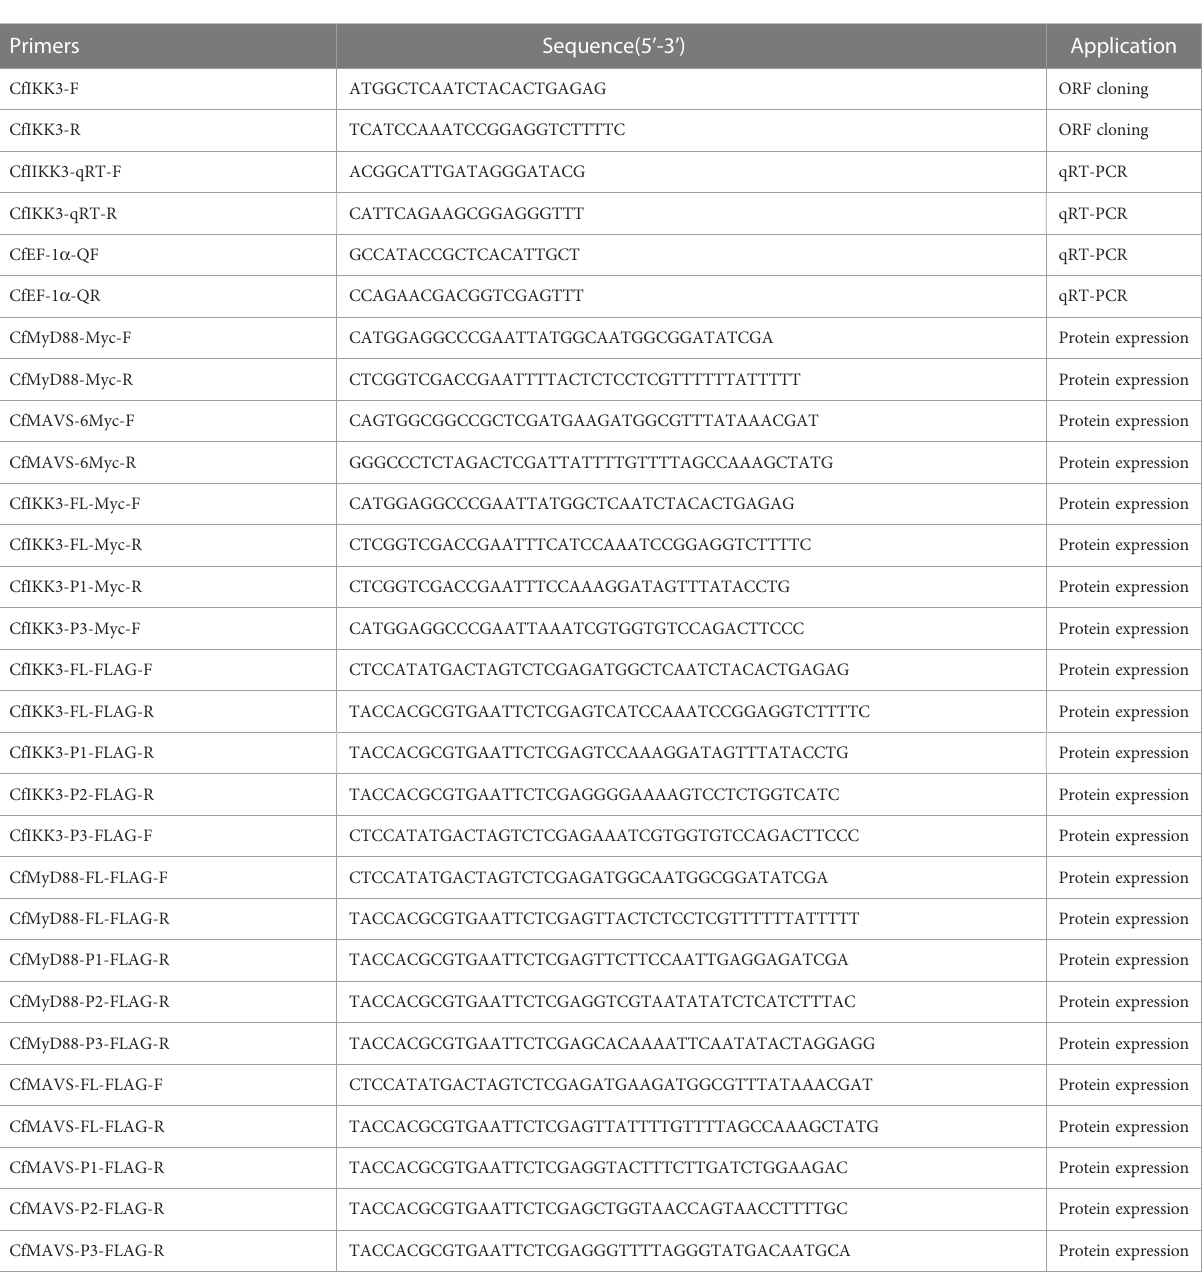
TABLE 1 Primers used in this